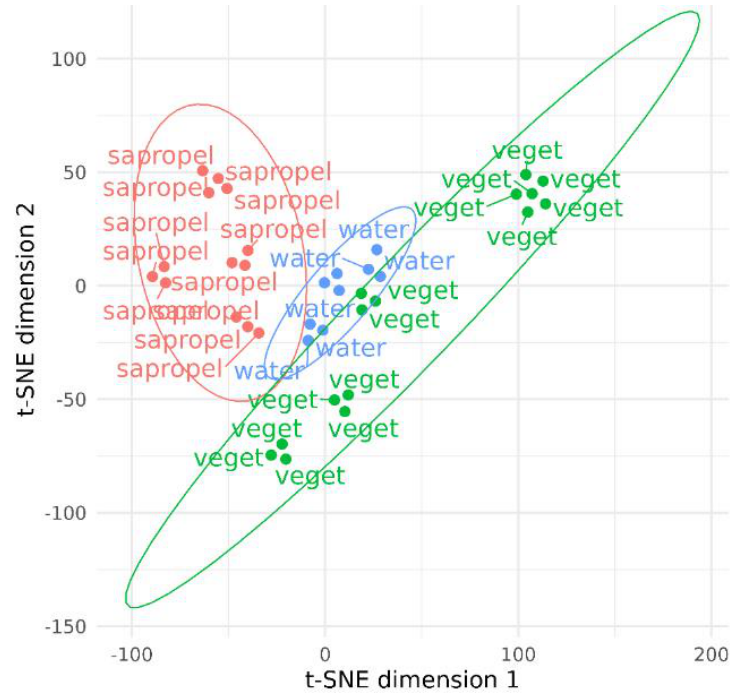
Figure 6. The t – SNE of habitats based on the abundance of ciliated protozoa. Figure 6. The t–SNE of habitats based on the abundance of ciliated